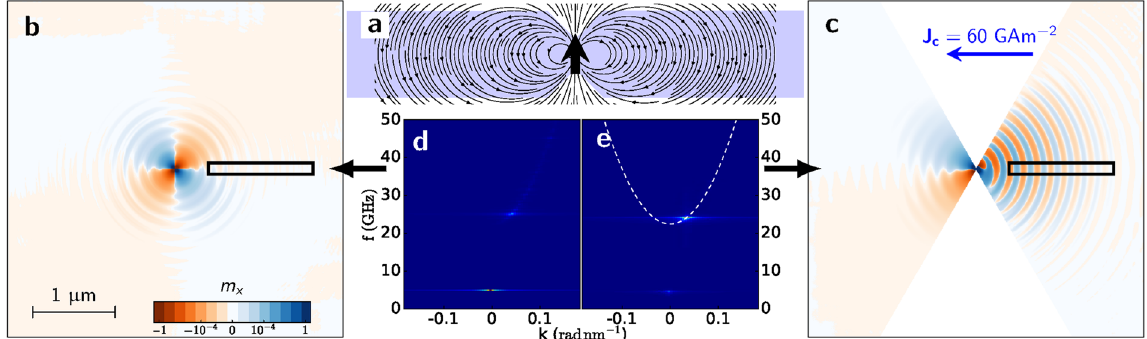
Figure 6. Comparison of the SW excitation caused by a rotating dipolar field and a pinned rotating DW. ( a) Schematic spatial configuration of the in-plane stray field generated by the DW. ( b) Snapshot of the magnetization dynamics in a thin film where the excitation is produced by a dipolar field located at the film centre rotating at 5GHz . ( c) Snapshot from simulations, where an applied current induces rotation of a DW pinned at the centre. ( d) − f k diagram extracted from the region indicated in ( b) , showing the non- propagating oscillation at 5 GHz and the propagating one at 25 GHz. ( e) f − k diagram showing propagation of SWs in the region indicated by the rectangle in ( c